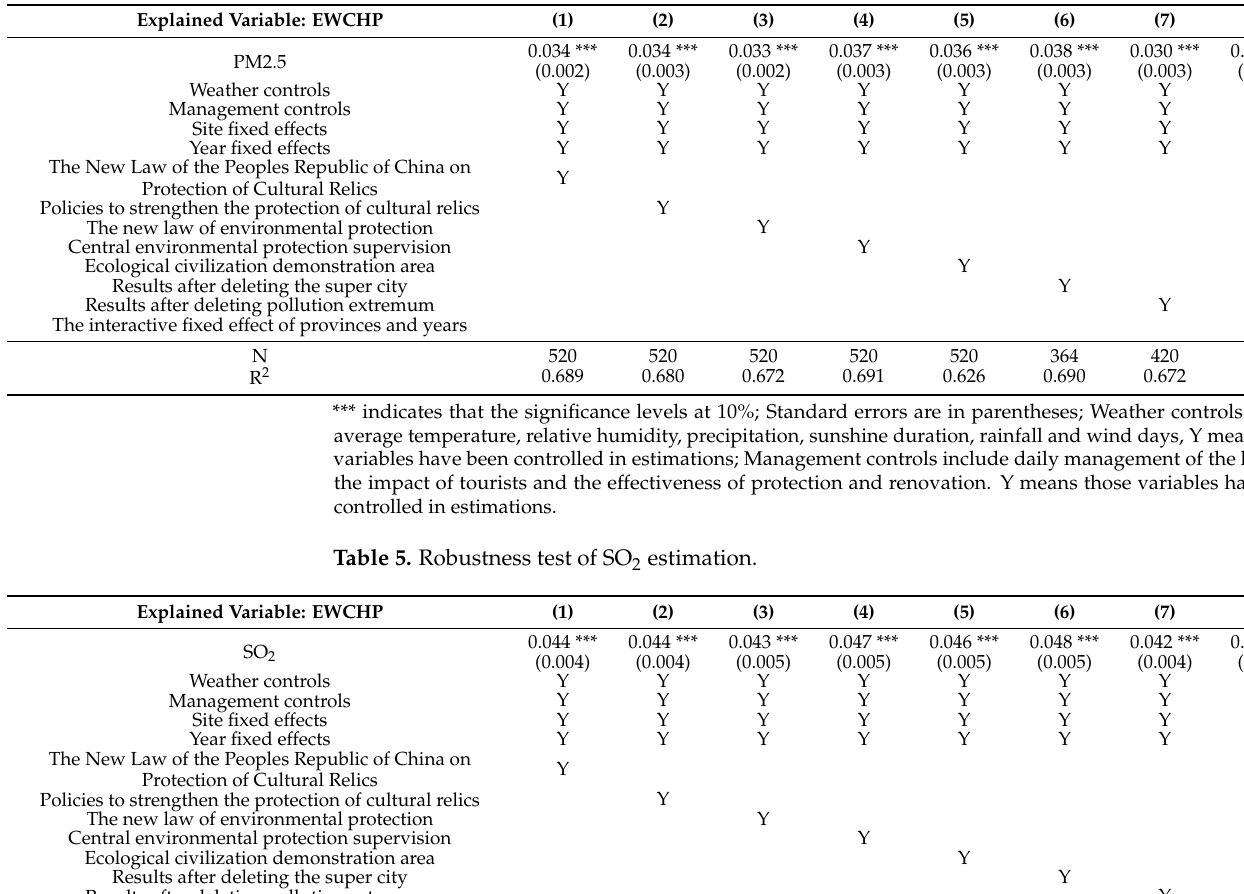
Table 4. Robustness test of PM2.5 estimates.